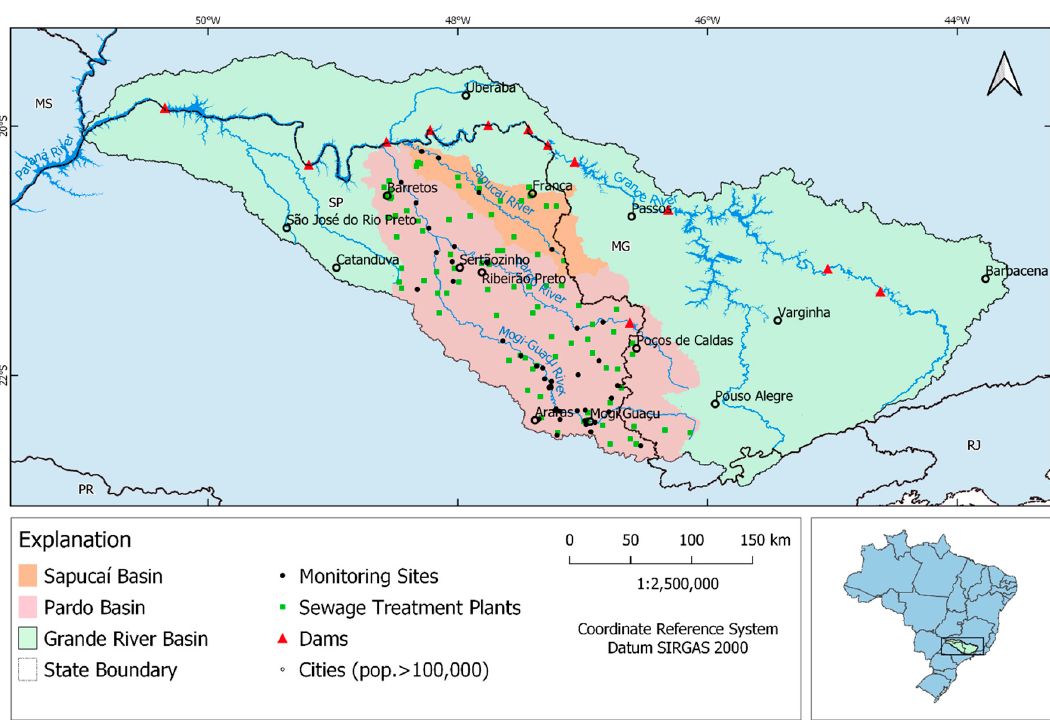
Figure 1. Map showing the study area, wastewater treatment plants, and stream monitoring sites in the basin.